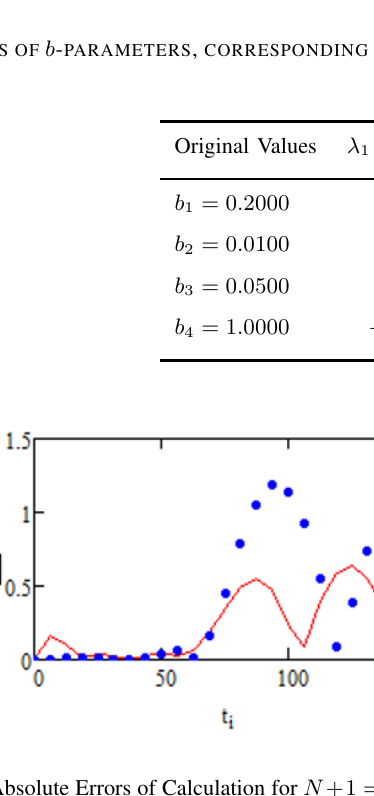
Fig. 7. Absolute Errors of Calculation for N +1 = 25 points (Differentiation method)